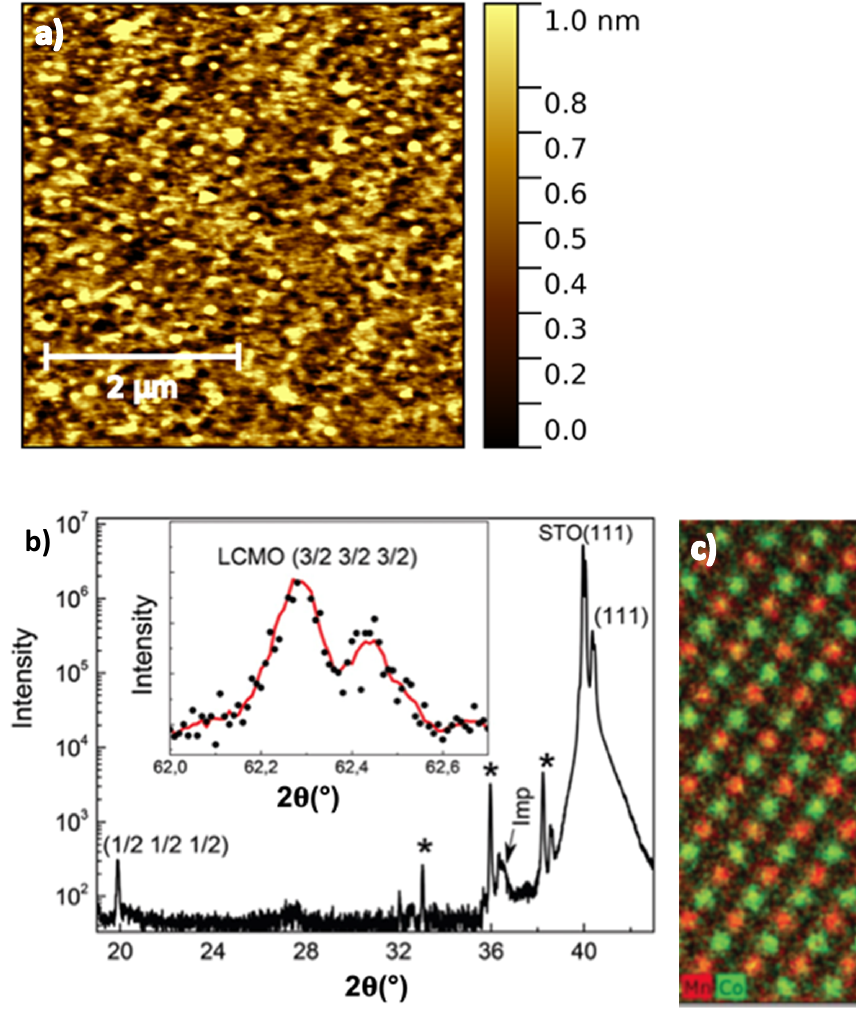
Figure 3. ( a ) AFM image of the surface morphology of a La 2 CoMnO 6 (LCMO) film grown by MAD technique on STO(111) substrate; ( b ) XRD pattern of the LCMO(111) film shows superstructure peaks and ( c ) short-range Co/Mn ordering evidenced by TEM-EELS mapping with Mn(red) and Co(green) dots. ( b , c ) are reproduced from Ref. [6] with permission from the European Society for Photobiology, the European Photochemistry Association, and The Royal Society of Chemistry.